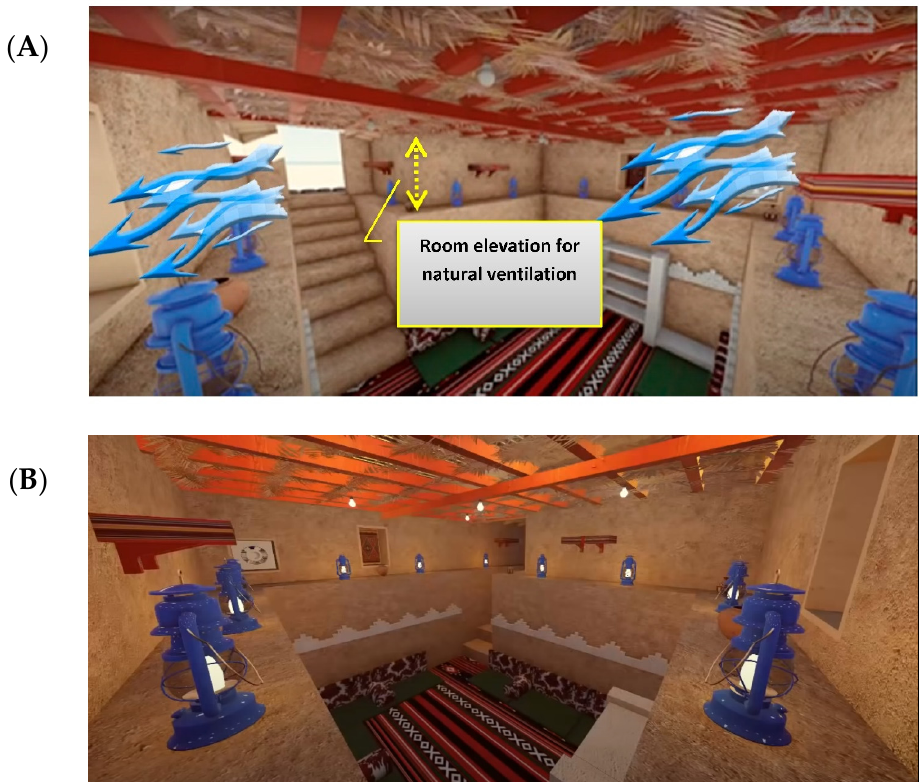
Figure 2. ( A ) is a view of the actual room model showing the 0.6 m elevation above ground level for the purpose of natural ventilation. ( B ) shows the night-time view of the room with traditional furniture.